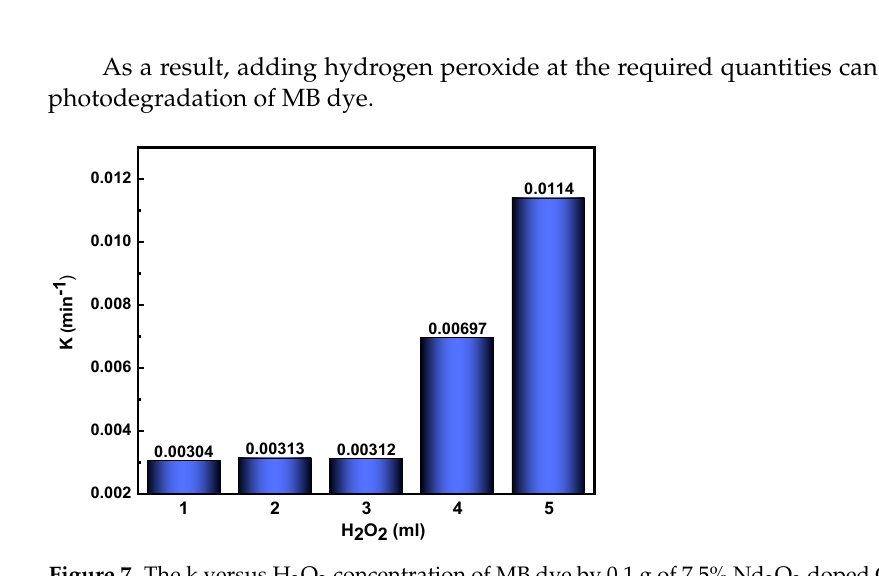
Figure 7. The k versus H 2 O 2 concentration of MB dye by 0.1 g of 7.5% Nd 2 O 3 doped CuO NPs under visible irradiation.